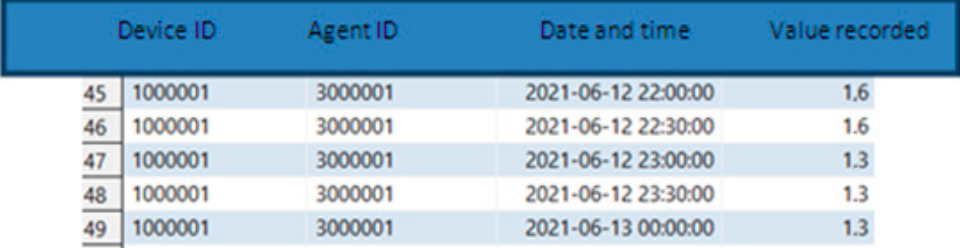
Figure 7. Stage 1. Raw data for electricity consumption.